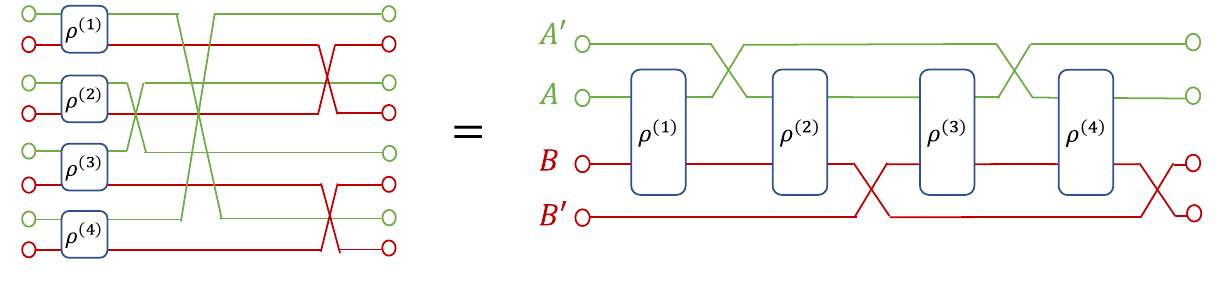
FIG. 6. The graphical expression of X 4 . The expression of X 4 =